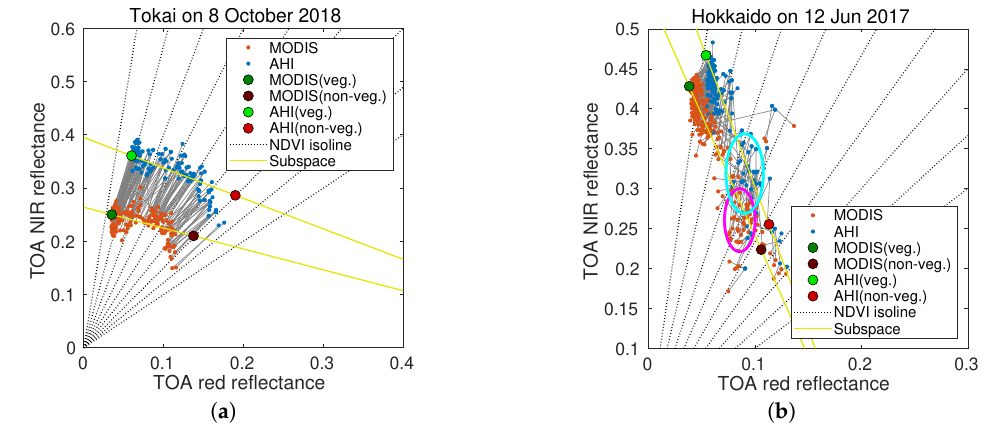
Figure 12. Scatter plot of the AHI and MODIS reflectance spectra and pseudo-endmember spectra for each sensor over the Tokai region for 8 October 2018 ( a ) and the Hokkaido region for 12 Jun 2017 ( b ). The red and blue dots indicate the MODIS and AHI reflectances over each area. The dark green and brown circles indicate pseudo- vegetation and non-vegetation endmembers for the MODIS